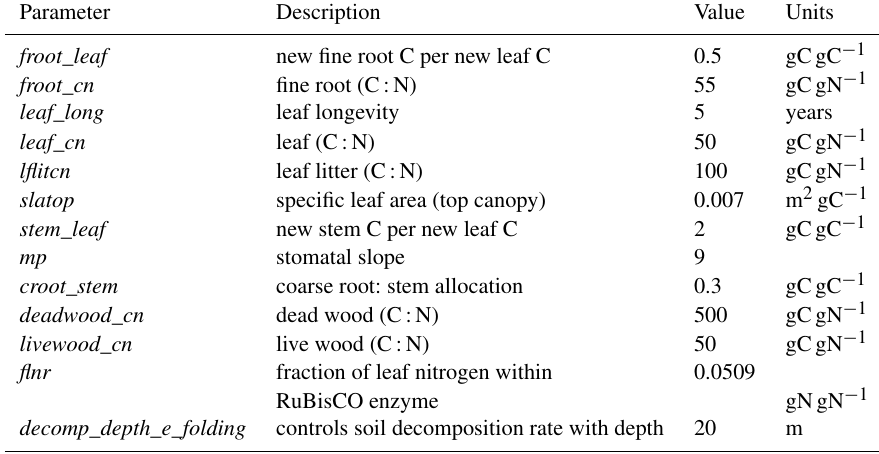
Table 3. CLM4.5 key parameter values for all model